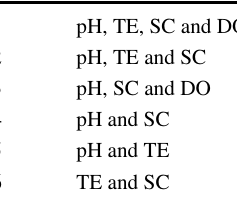
*17,520: data measured at 30-min interval of time, thus: 365 days × 24 × 2 = 17,520 patterns; 35,040: data measured at 15-min interval of time, thus: 365 days × 24 × 4 = 35,040 Table 5 Structure of the developed models